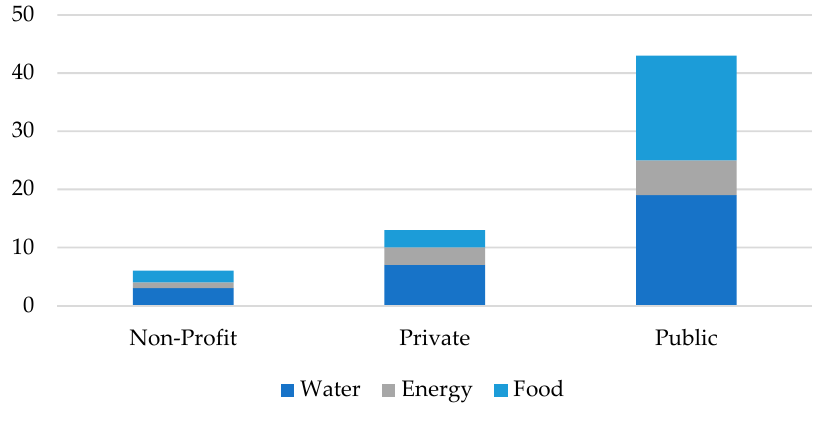
Figure 4. Visual representation of Nexus sectors of interest for stakeholders as a percentage of the type of organization. The vertical axis indicates the number of stakeholders. Universities are not included.